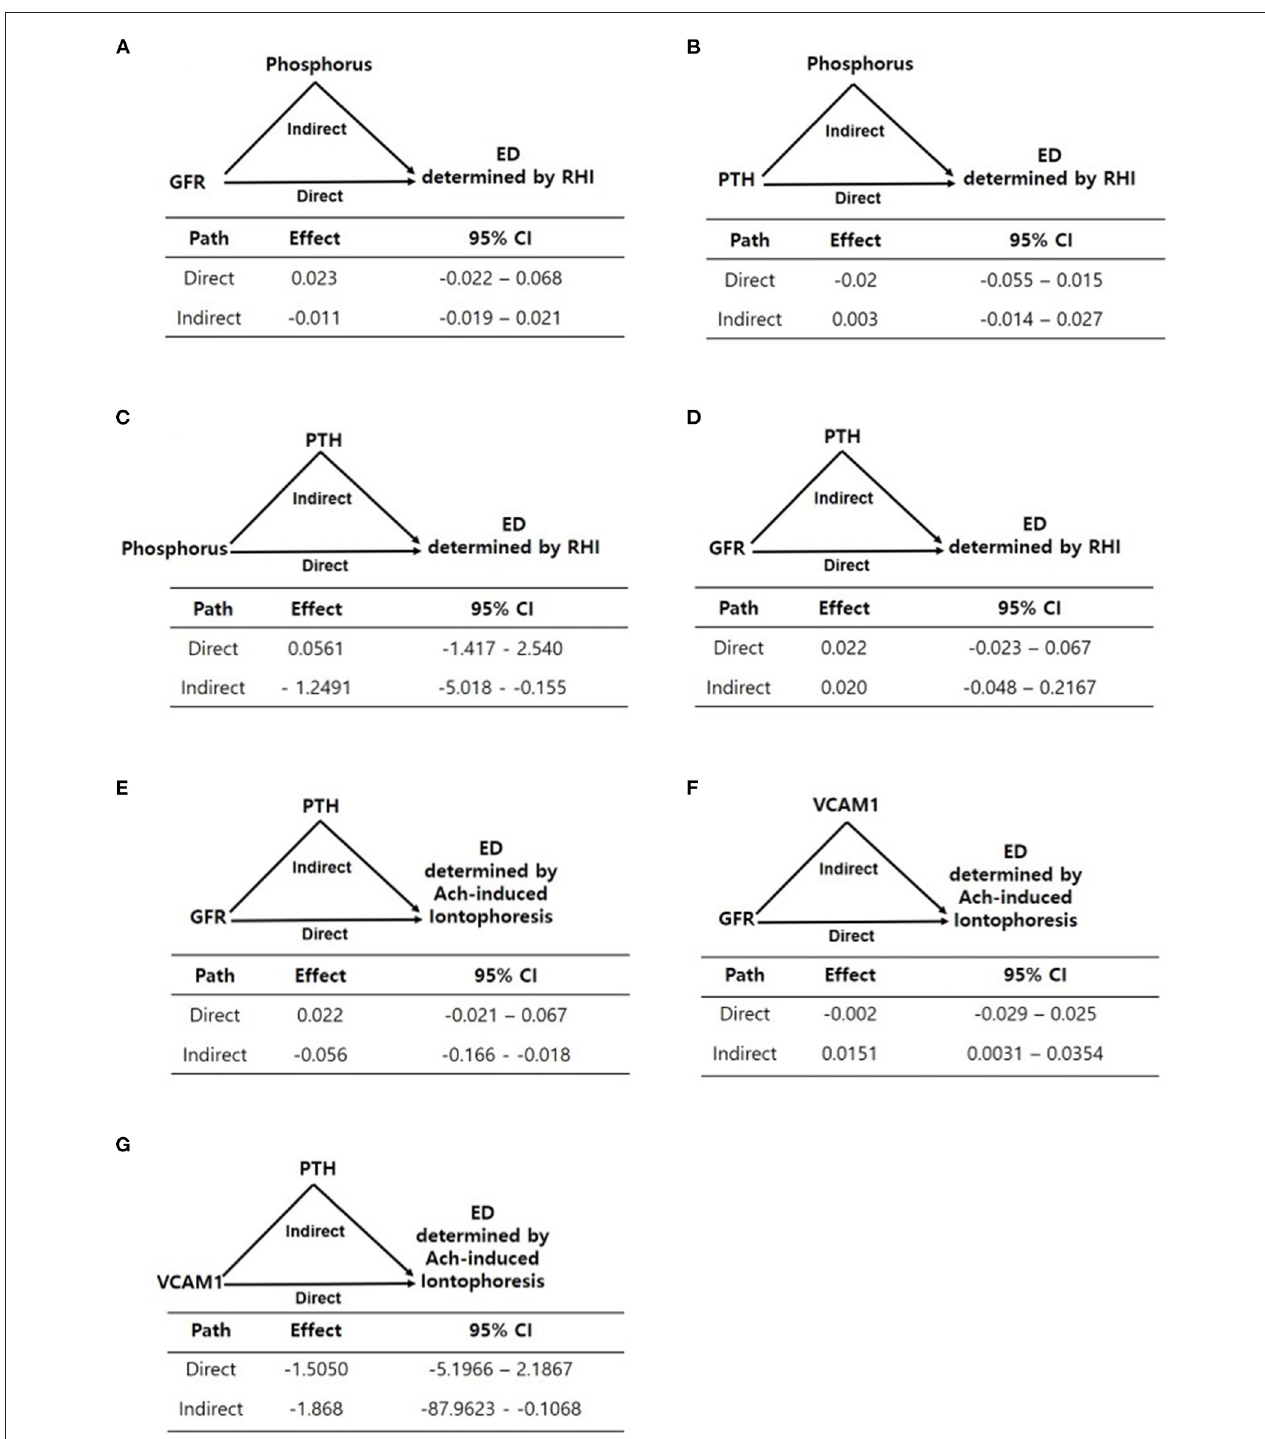
FIGURE 2 | (A–G) Mediation analyses of the associations between variables including eGFR, phosphorus, PTH, and endothelial dysfunction determined by EndoPAT and laser doppler iontophoresis. Path models and mediation analyses describe mediation of the association between variables and endothelial dysfunction through endothelial-related biomarkers individually. Path effects are reported as Odds-ratio scale of natural log-transformed values of biomarkers.